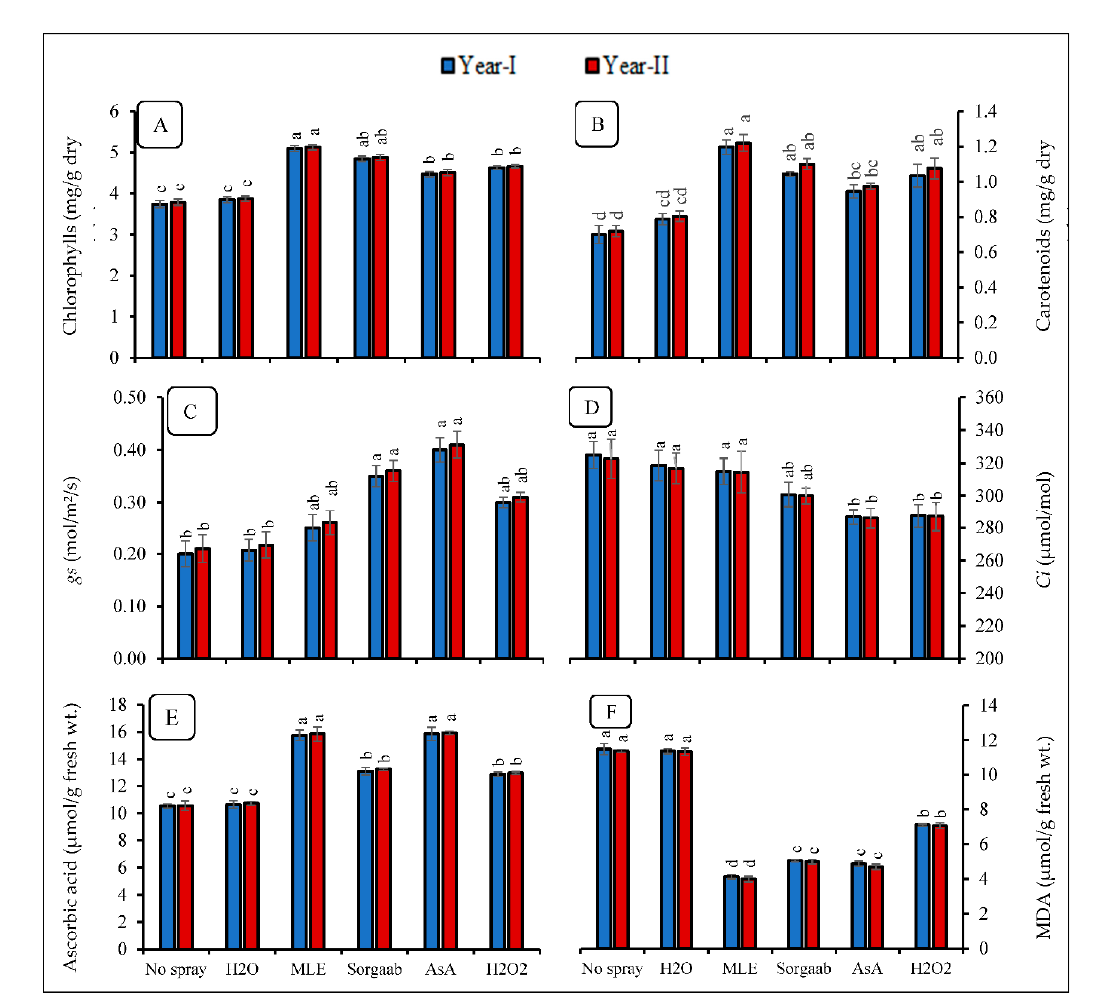
Figure 2. Influence of plant growth promoters on chlorophyll contents ( A ), carotenoids ( B ), stomatal conductance ( C ), sub-stomatal CO 2 concentration ( D ), ascorbic acid ( E ), and MDA ( F ) of quinoa cultivated during the growing seasons